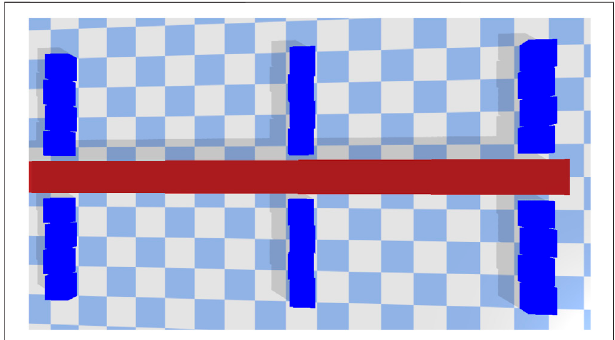
FIGURE 11 | Baseline design. Legs are constructed using four cubes with each having upper-mid-level material properties (friction (cid:2) 0.75, restitution (cid:2)